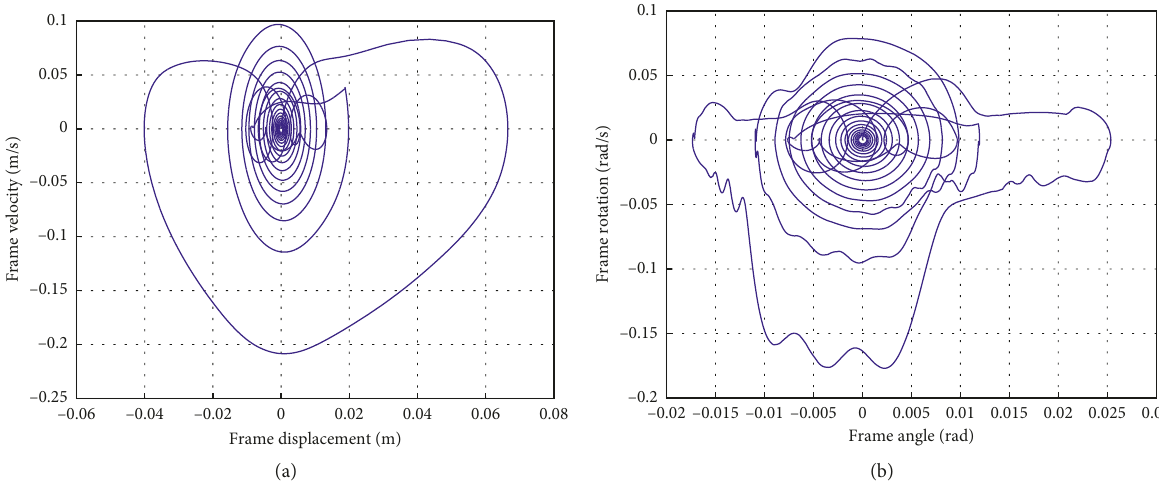
Figure 16: Random load followed by free vibration. (a) The displacement-velocity phase plane and (b) the angle-rotation phase